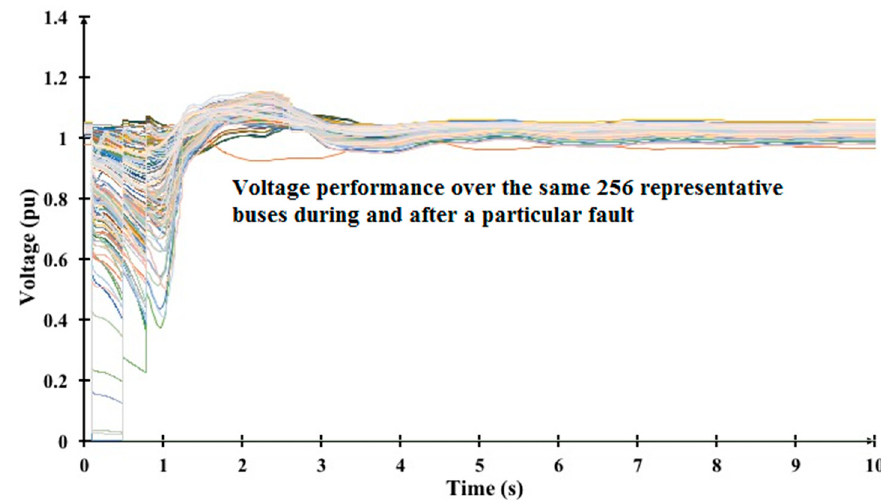
Figure 8. No voltage sags for dispatch SLL 1 .